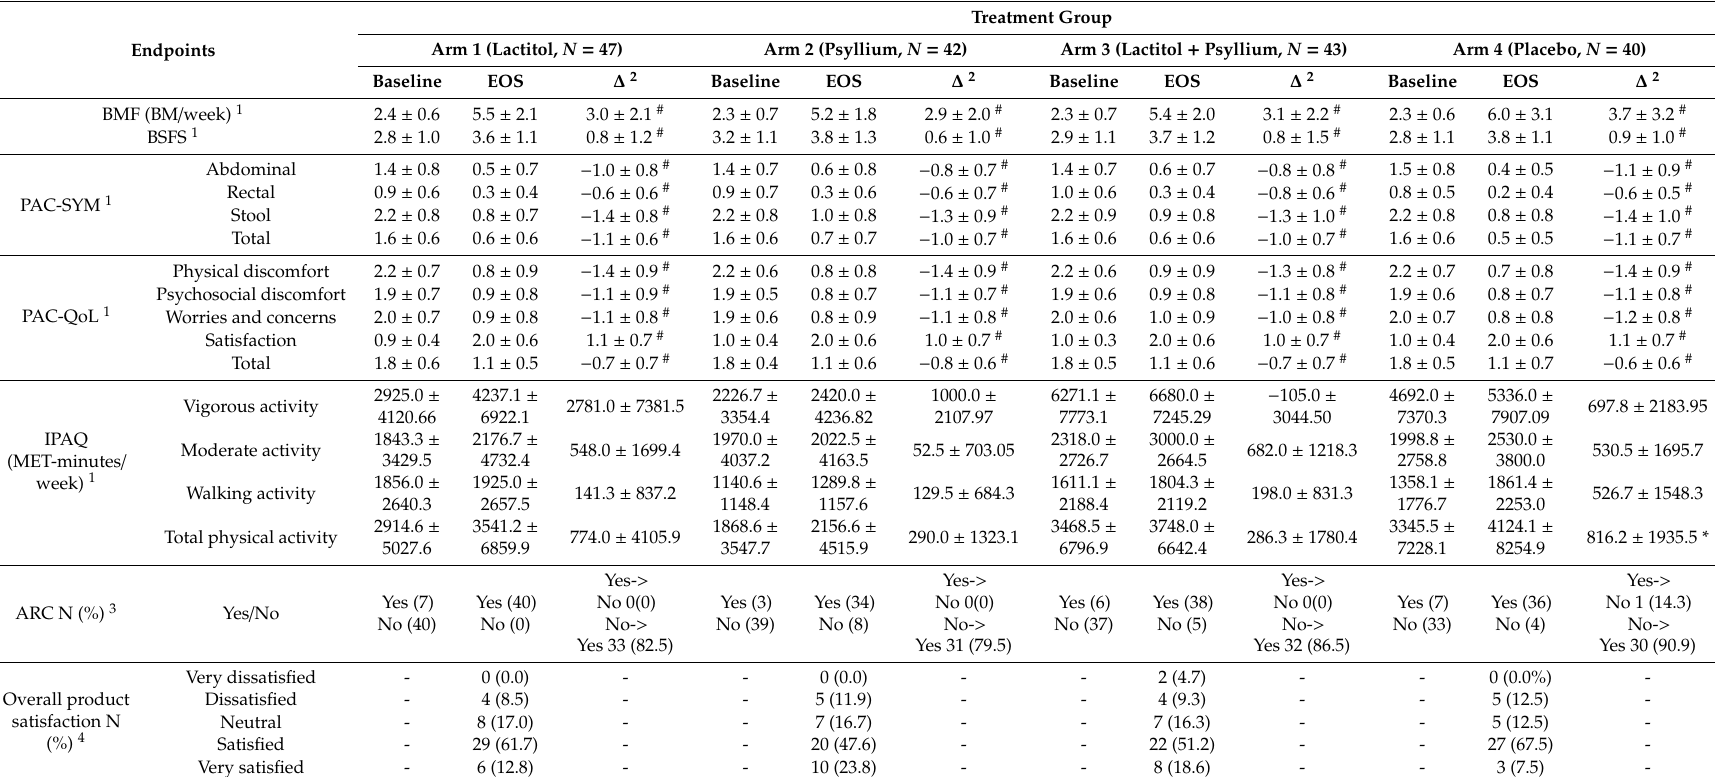
Table 3. Summary of Actual value and Change from Baseline (V3) for main endpoints in ITT